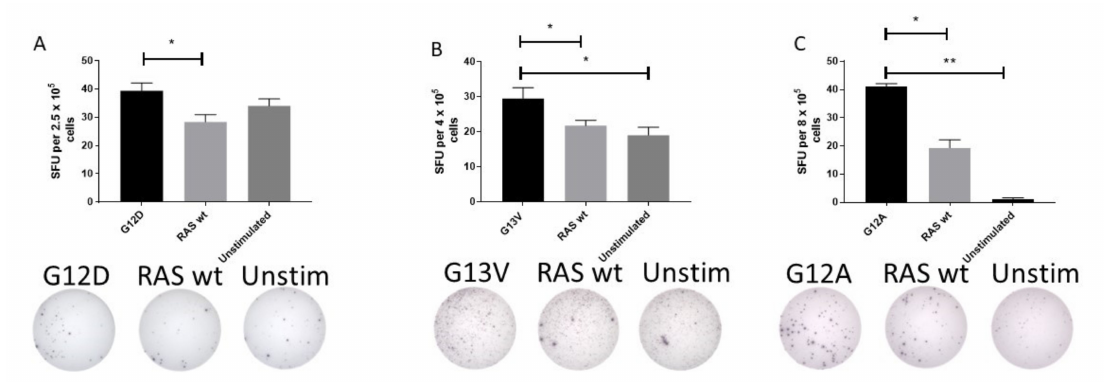
Figure 2. Ex vivo immune responses against mutant epitopes in three di ff erent healthy donors, with the wild-type (wt) epitope and unstimulated cells as negative controls. Healthy donor peripheral blood mononuclear cells were thawed and rested over night before they were plated directly ex vivo into the ELISPOT plate and stimulated with the appropriate peptides for 48 h before development of the plate. The experiments included both wt peptide-stimulated cells and unstimulated cells as negative controls. Response to G12D ( A ), G13V ( B ), and G12A ( C ) epitopes are shown. * indicates a DFR-defined response, whereas ** indicates a DFR(2x) defined response